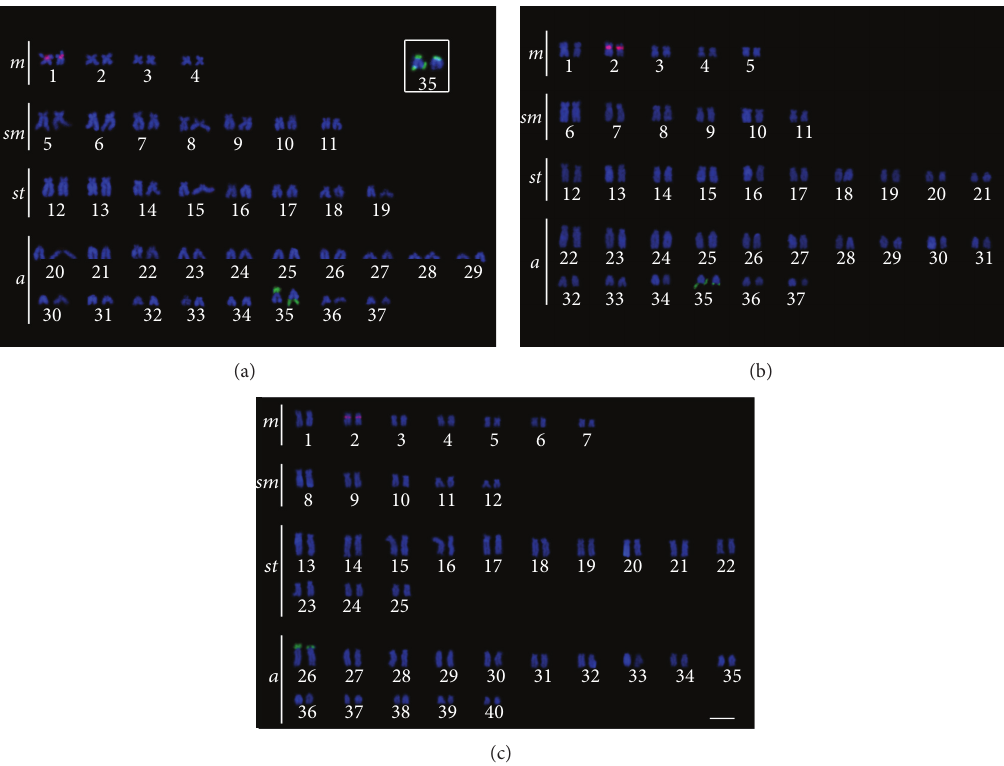
Figure 3: Double FISH karyotypes with 5S rDNA probes (rhodamine, red) and 18S rDNA probes (FITC, green) of (a) Hypostomus albopunctatus , with a variation of the position of the 18S rDNA sites evidenced on the box; (b) Hypostomus aff. paulinus and (c) Hypostomus topavae . The bar represents 5 𝜇 m.